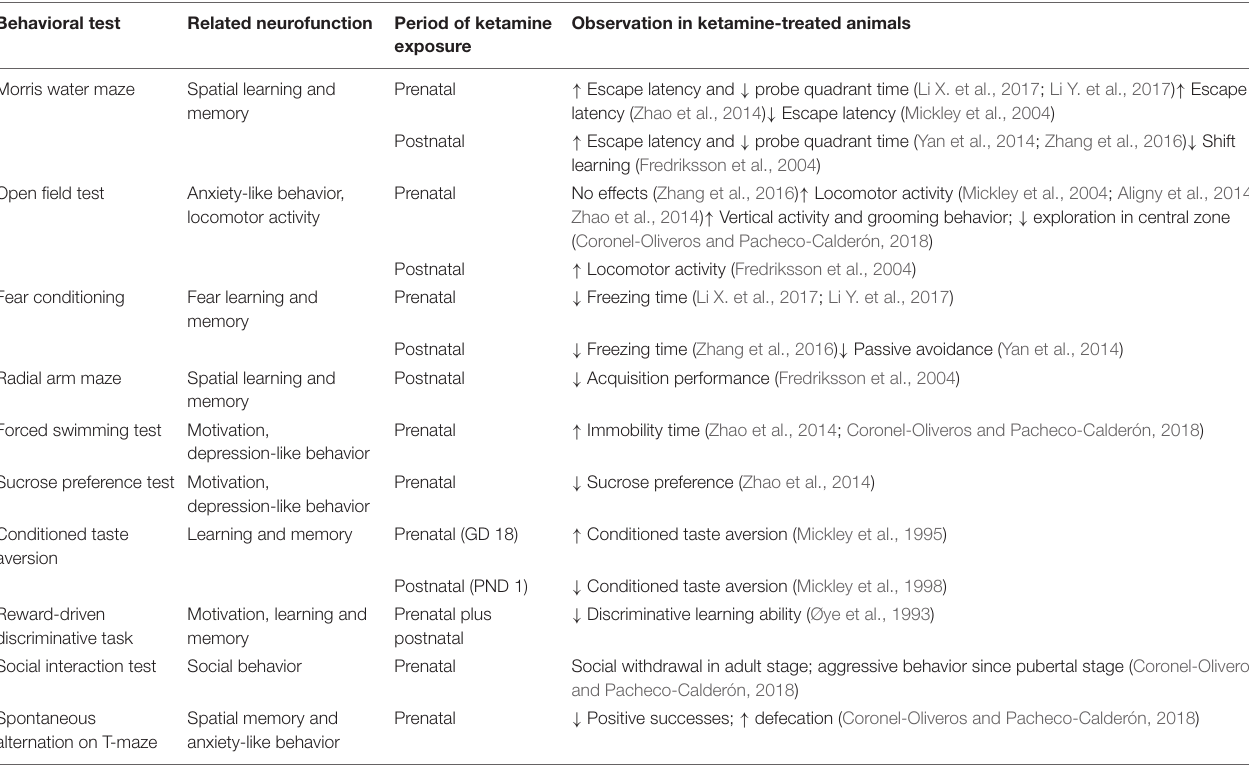
TABLE 2 | Summary of the effects of perinatal exposure to ketamine on rodent behavior. Behavioral